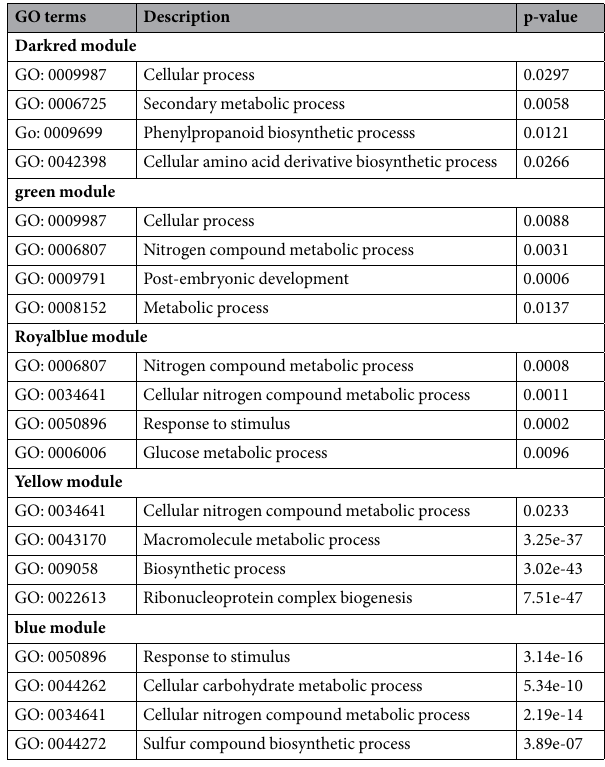
Table 2. Table representing enriched GO terms in darkred, green, royalblue, yellow modules of PB and blue module of